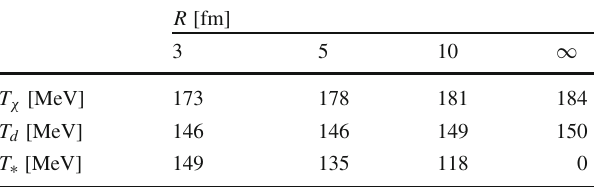
Table 4 Same as in Table 1 but for the Polyakov loop potential of Fukushima, version U F 2